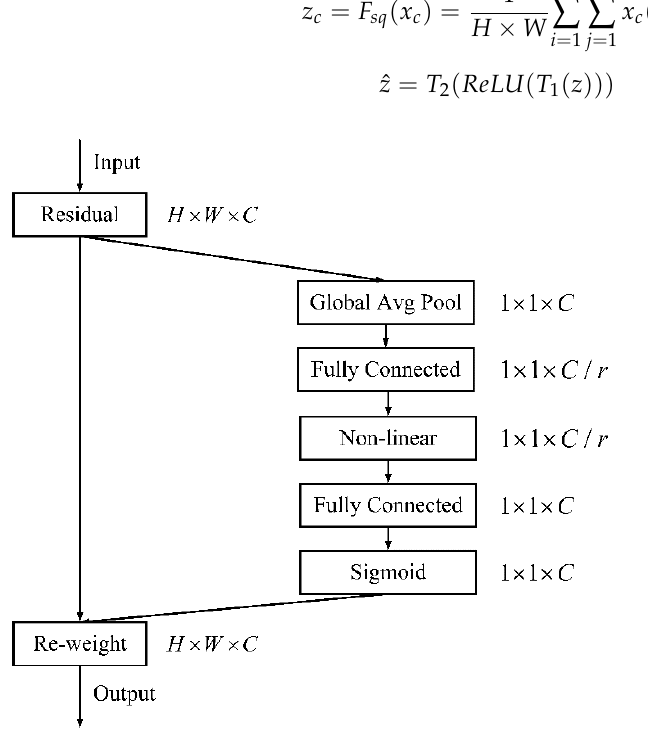
Figure 9. Schematic diagram of SE attention mechanism module.